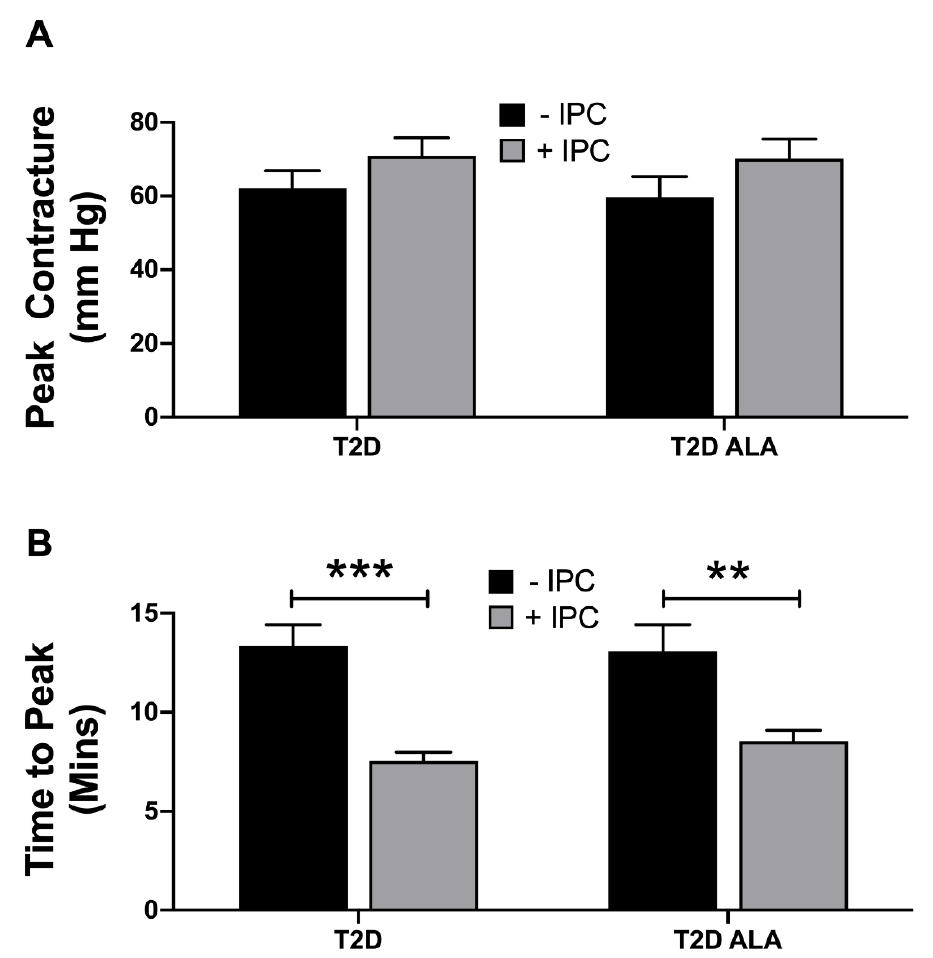
Figure 2. Ischemic contracture in untreated ( − IPC) and preconditioned ( + IPC) hearts from T2D mice ± dietary ALA supplementation. Data are shown for ( A ) peak contracture during 25 min ischemia; and ( B ) time to reach peak contracture. Results presented as means ± SEM (T2D ( − IPC), n = 8; T2D ( + IPC), n = 7; T2D + ALA ( − IPC), n = 8; T2D + ALA ( + IPC), n = 8). **, p < 0.01; and ***, p < 0.001.